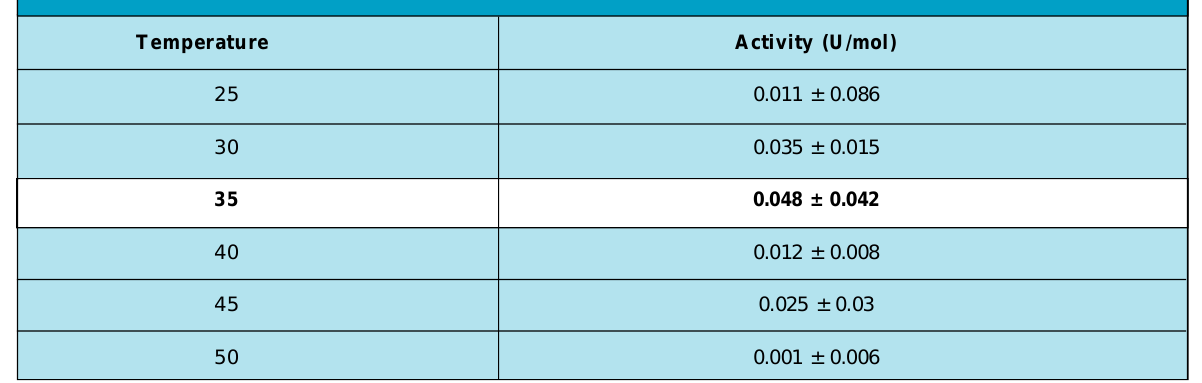
Table 4: Effect of temperature on alpha amylase activity